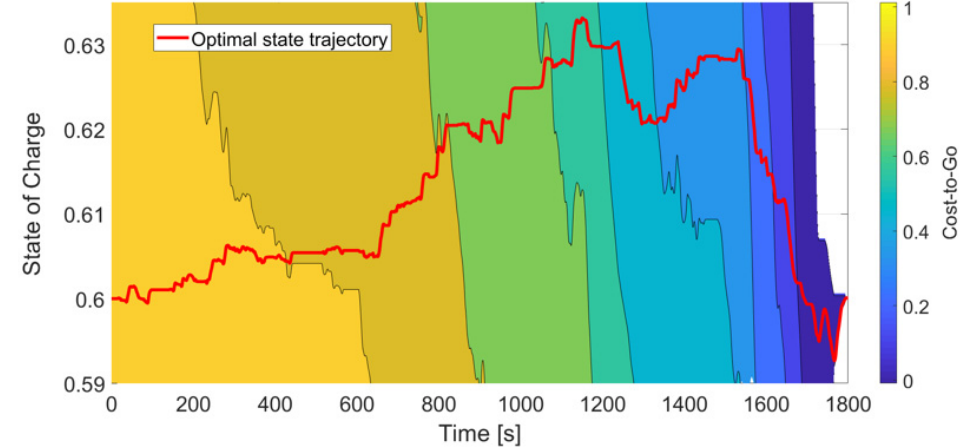
Figure 2. Cost-to-go map and optimal state trajectory obtained with DP optimization on the WLTP driving cycle ( Q = M = 2000).